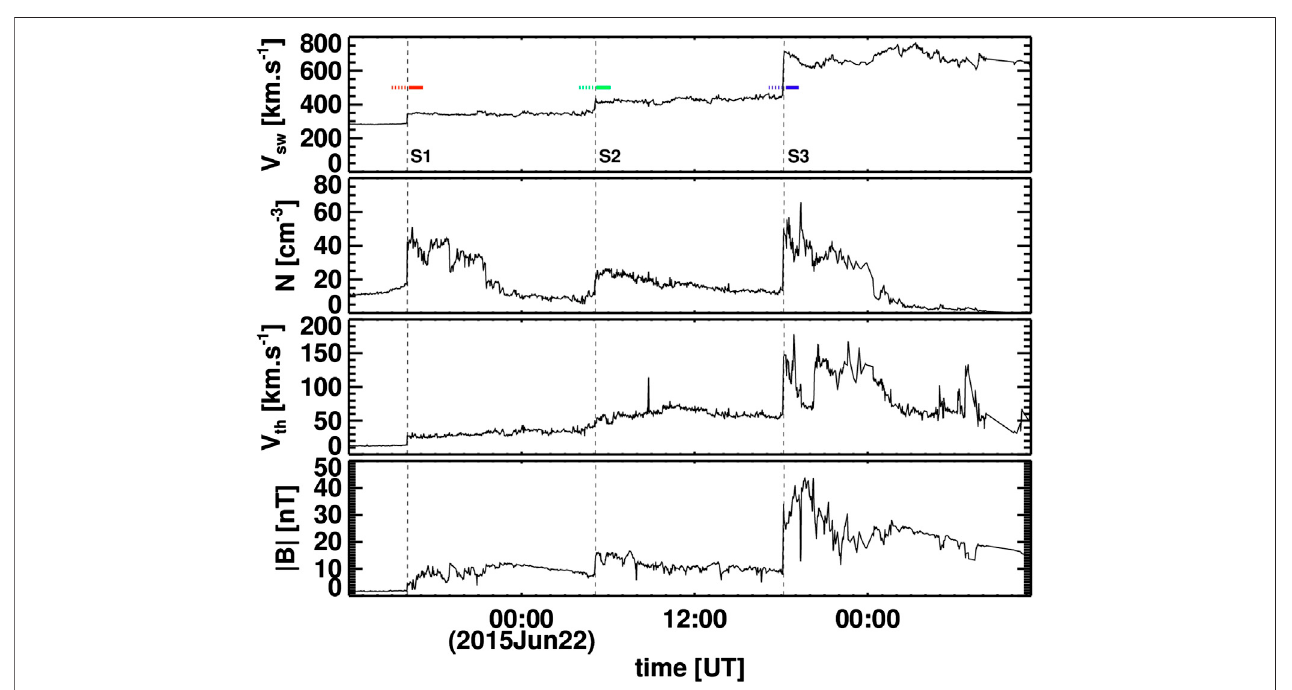
FIGURE 4 | Bulk parameters of the solar wind during 2 days when Wind encountered three quasi-perpendicular fast forward IP shocks. From top to bottom: Pro fi les of the solar wind velocity, V sw , density, N , thermal speed, V th , and magnetic fi eld magnitude, B . Dashed vertical lines show IP shock fronts. Colored horizontal linesmarktheintervalsforestimationsofthepowerspectraofmagnetic fi eld fl uctuationsin Figure5 .Dashed/solidlinescover1 hupstream/downstreamofeachshock (excluding 5 min adjacent to the shock front).